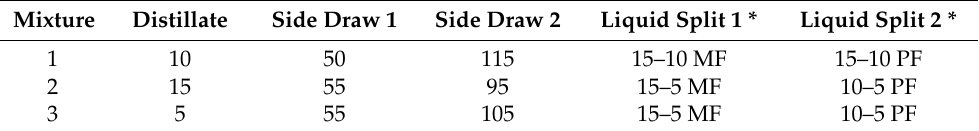
Table 3. Selected temperature stages for temperature control of the respective manipulated variable.